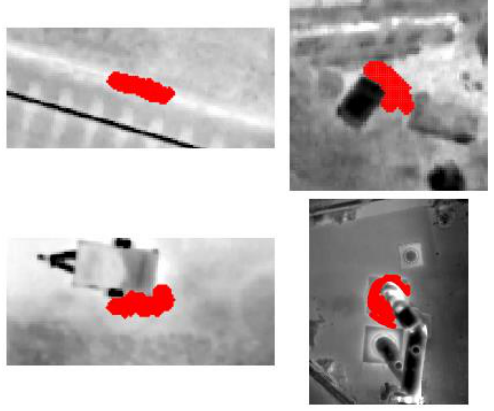
Figure 9 Anomaly examples – other manmade